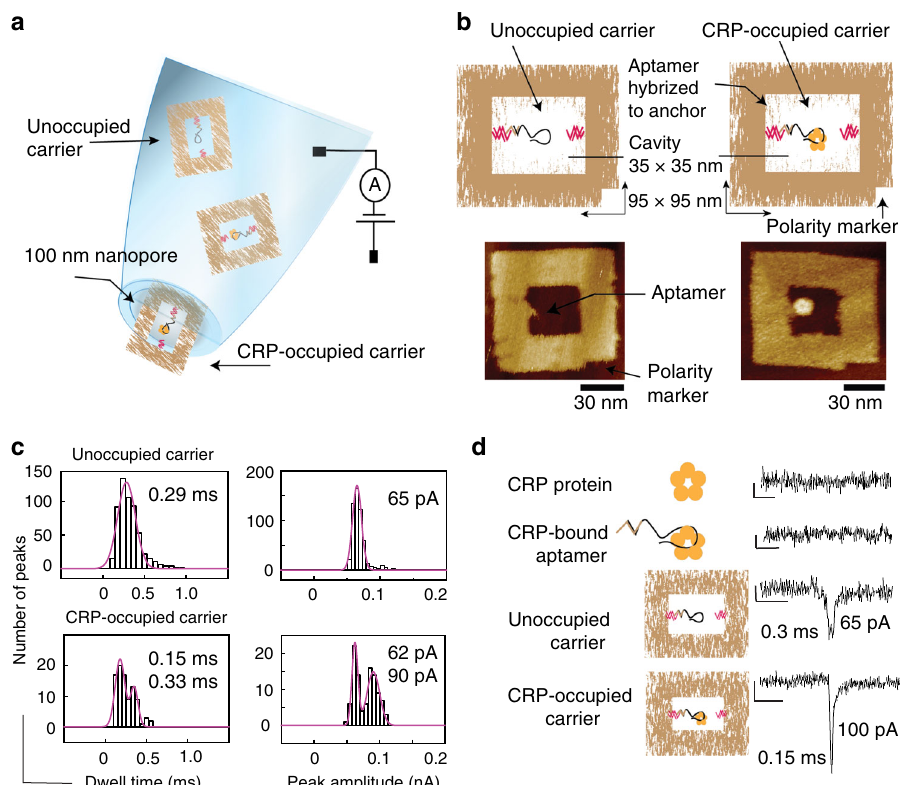
Fig. 2 DNA origami carrier-based biosensors. a Schematic representation of the DNA nanostructure-based biosensing concept exploiting translocation through nanopipettes as the sensing mechanism. b Schematic representation of the design and representative AFM micrographs of the unoccupied and occupied DNA origami carriers. The frame DNA nanostructure is ~95 nm × 95 nm in dimension with a 35 nm × 35 nm inner cavity. The DNA origami comprises small nucleotide ‘ anchors ’ that protrude into the cavity which facilitate the incorporation of the DNA aptamer via hybridisation. The DNA carrier also includes a polarity marker. c Peak amplitude and dwell time histograms of DNA nanostructure carriers (9 nM) and carriers incubated with CRP at 9 nM concentration, both measured at a fi nal carrier concentration of 500 pM. d Typical ion current signatures upon translocation of CRP molecules, CRP – DNA aptamer complexes, unoccupied carriers and CRP-bound occupied carriers. The scale bars represent 20 pA and 1 ms, respectively. Source data are in the Source Data fi